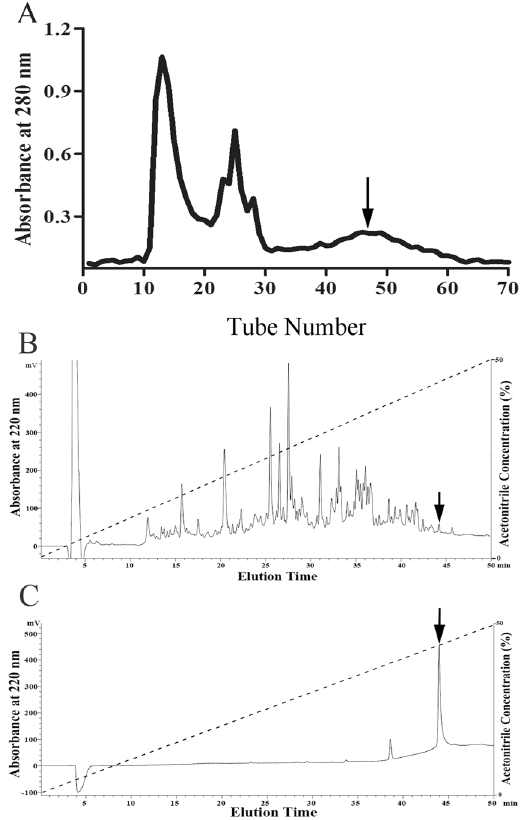
Figure 1. Peptide purification procedure from O. andersonii skin secretions. Skin secretions of O. andersonii were separated by a Sephadex G-75 gel column, with the peak exhibiting ABTS + free radical scavenging activity indicated by an arrow. ( B ) Eluted peak in ( A ) showing ABTS + free radical scavenging activity was collected for further purification using a RP-HPLC column. ( C ) Sample exhibiting ABTS + free radical scavenging activity (indicated by arrow in ( B )) was collected for further purification using a RP-HPLC column. A peptide with ABTS + free radical scavenging activity was obtained (indicated by an arrow in